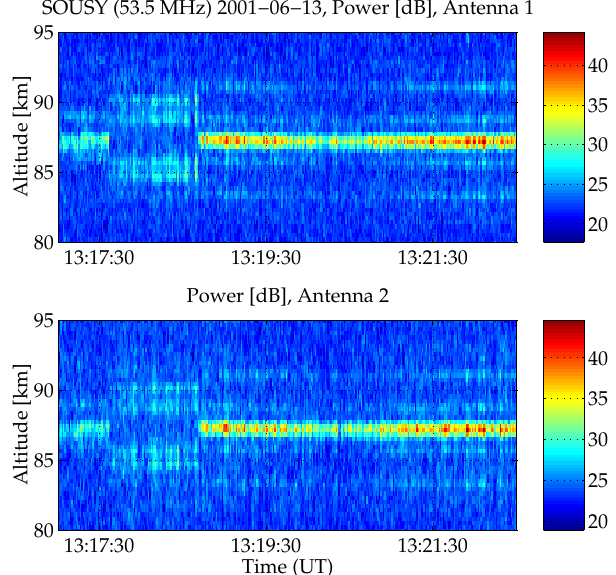
Fig. 5. Down-conversion and filtering is sufficient to produce some traditional radar data products, such as Range Time Intensity plots. Here data from an experiment using the SOUSY Svalbard radar taken using a MIDAS derived software radar system is shown. A PMSE layer is visible in the data. The secondary layering seen is most likely an artifact due to a mismatch between the sampling rate of the data system and the baud length of the complementary code sent by the